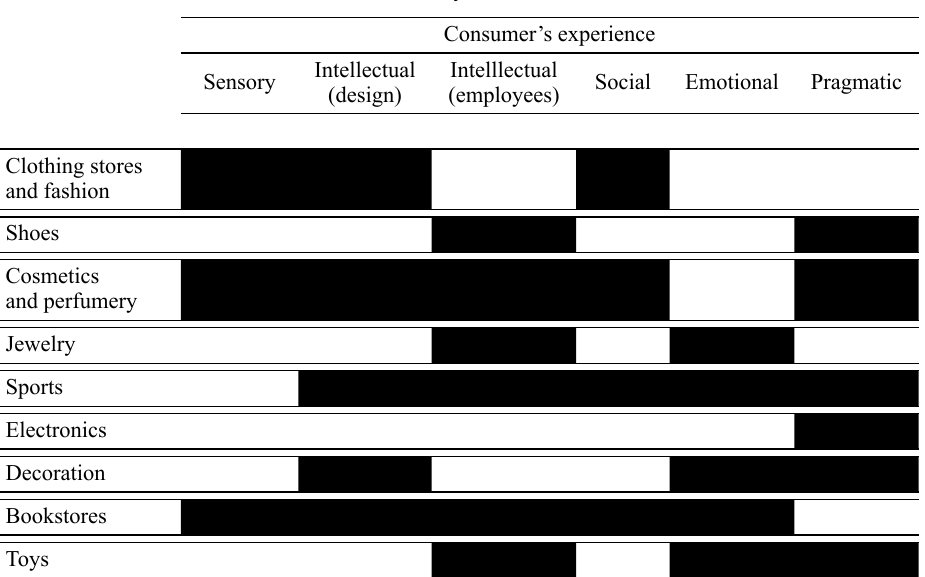
Table 6. Survey’s main